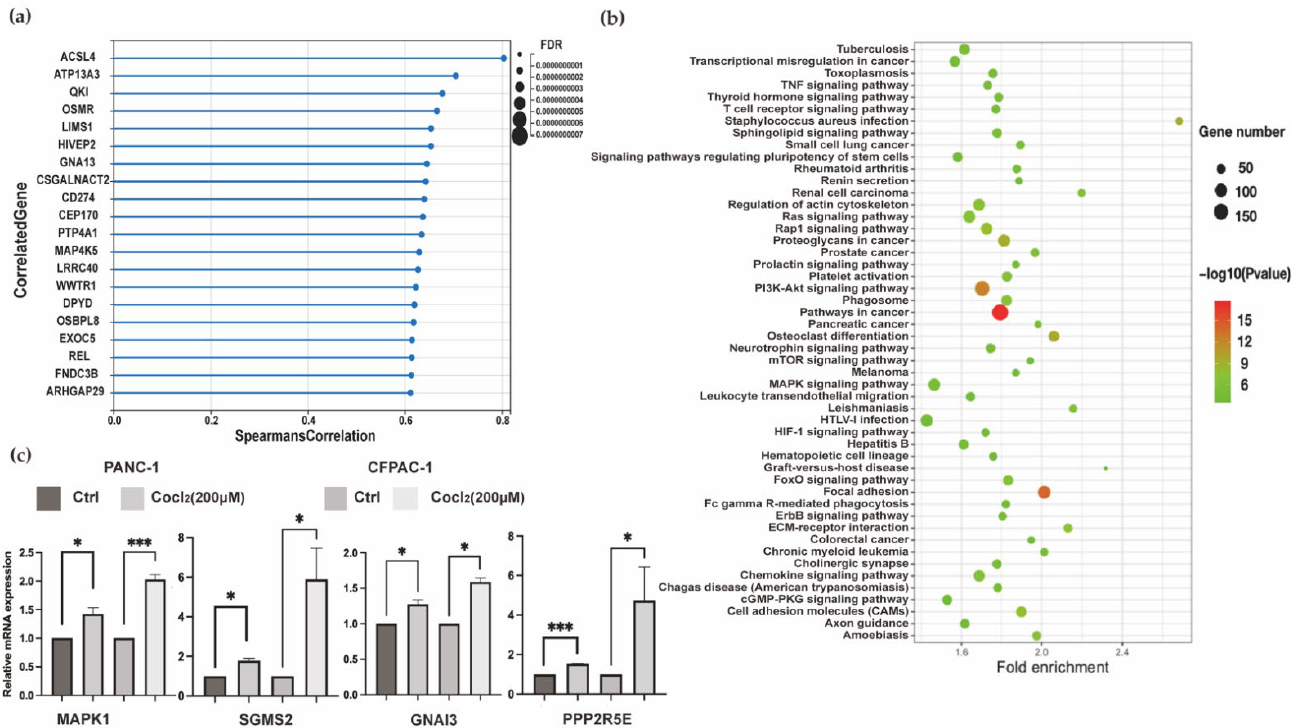
Figure 3. Identification of HIF- 1α -related genes and biofunction by bioinformatics analysis. ( a ) Statistical chart of the top 20 genes positively related to HIF- 1α. ( b ) The KEGG pathways enriched in genes selected by Spearman’s correlation coefficient analysis. ( c ) The mRNA expression of genes involving in sphingolipid signaling pathway in two cell lines. (n = 3. *, p < 0.05; ***, p < 0.001). (FDR:false discovery rate) (TCGA: https://portal.gdc.cancer.gov/, accessed on 17 May 2021).